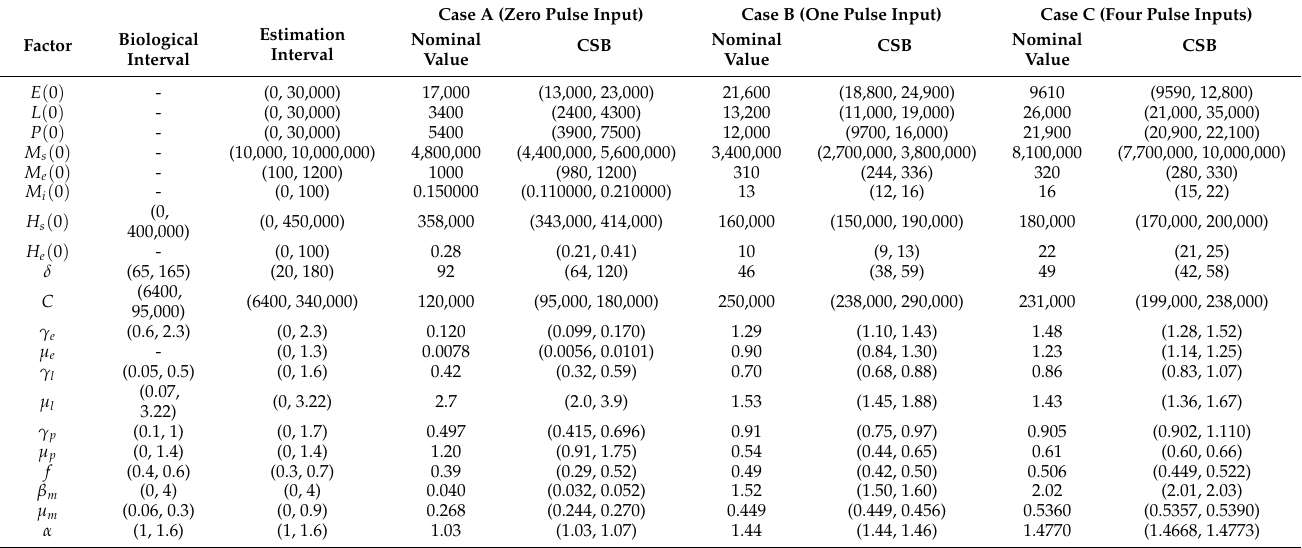
Table 2. Estimated nominal values and confidence sub-contours for parameters and initial